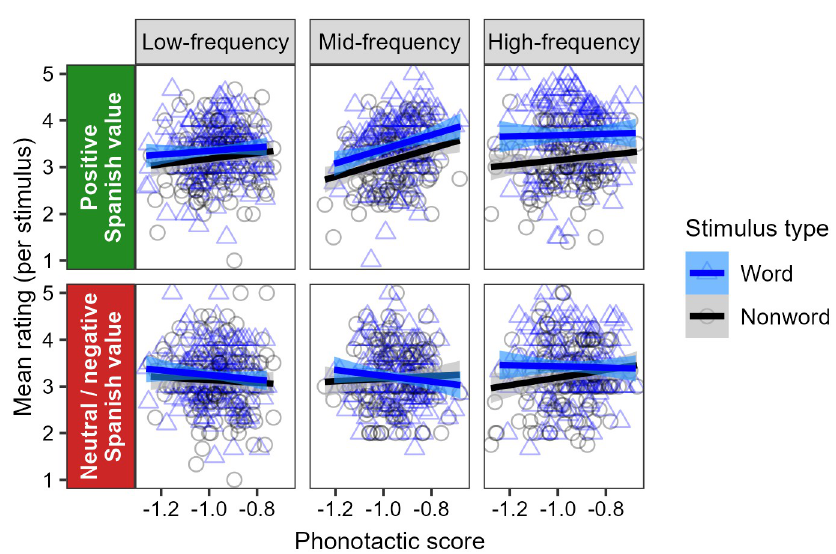
Fig 5. Summary of raw results from Experiment 1, showing participants’ mean wordhood confidence ratings for each stimulus per frequency bin, and their relation to phonotactic score, separating participants with positive Spanish value (top facets) from those with neutral/negative Spanish value (bottom facets). Points represent mean ratings for each real word (blue triangles) and nonword (black circles) within each bin, and straight lines show correlations with phonotactic scores. Participants with positive Spanish value show a separation between ratings for words and nonwords, which grows with word frequency, and give higher ratings as phonotactic score increases; participants with negative Spanish value show neither pattern